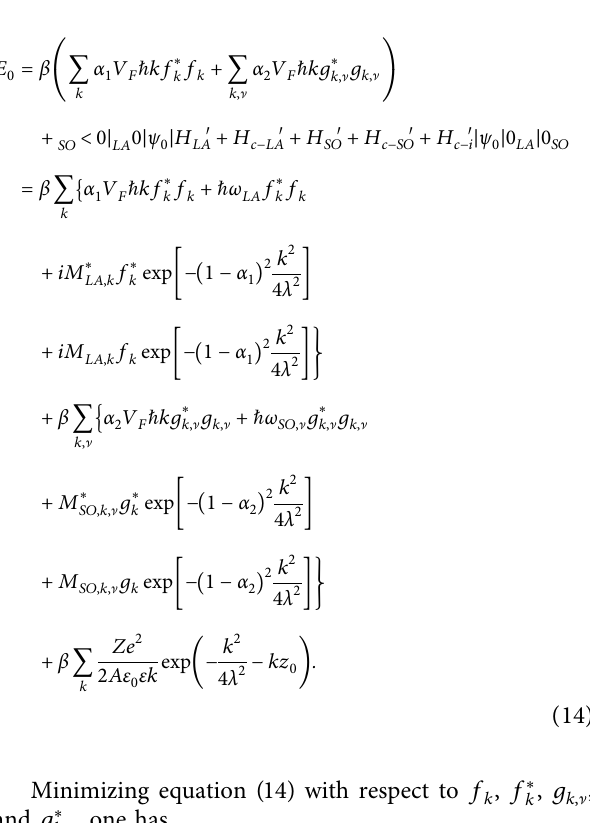
Figure 1: A schematic diagram of air/monolayer graphene/substrate. (a) indicates the positions of an electron in the monolayer graphene plane and a Coulombic impurity in the substrate, and (b) indicates the Coulombic potential in the graphene plane induced by the impurity located at a distance z under the graphene 0